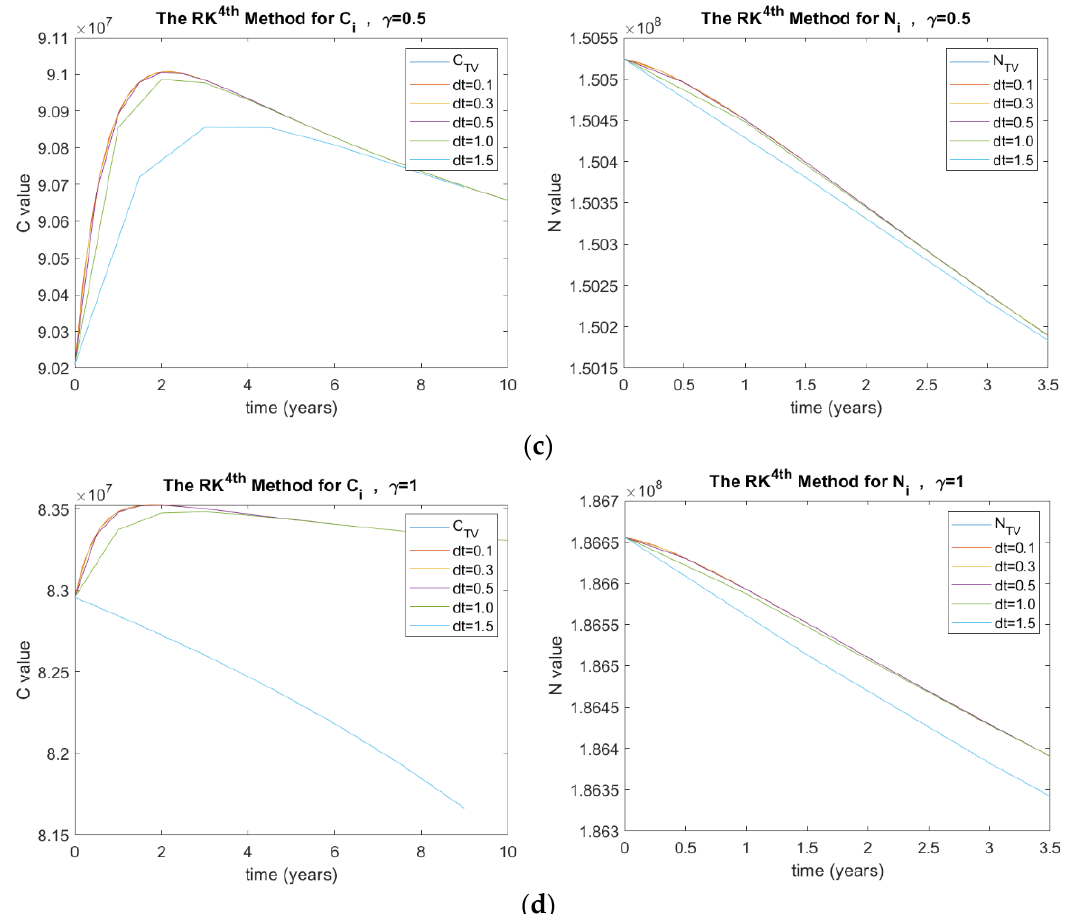
Figure 3. ( a ) Stability analysis for RK method when γ = 0.04 , ( b ) γ = 0.08 , ( c ) γ = 0.5 , and ( d ) γ = 1.0, where C is the number of diabetic patients with complications and C TV is its true value, N is the total number of people with diabetes and N TV is its true value, and d t is the time step size. Probability of Developing a Complication ( λ ) The investigated λ values in this paper are 0.04, 0.66, 0.85, and 1.2. Figure 4 shows the results of C i and N i for the RK method in terms of λ and ∆ t , where (a) λ = 0.04, (b) λ = 0.66, and (c) λ = 0.85. The Mortality Rate Due to Complications ( δ ) The investigated δ values in this paper are 0.02, 0.05, 0.1, and 0.35. Figure 5 shows the results of C i and N i for the RK method in terms of δ and ∆ t , where (a) δ = 0.02, (b) δ = 0.05, (c) δ = 0.1, and (d) δ =